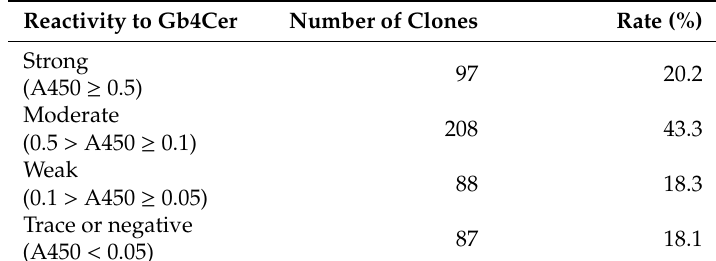
Table 1. Frequency of hybridoma clones producing anti-Gb4Cer antibodies.